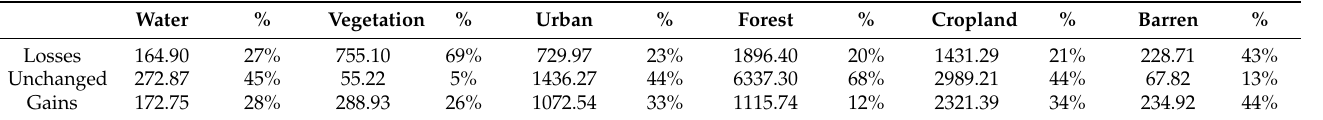
Table 3. The land area gained, lost, and unchanged (km2) of LUCC classes from 2004 to 2019.